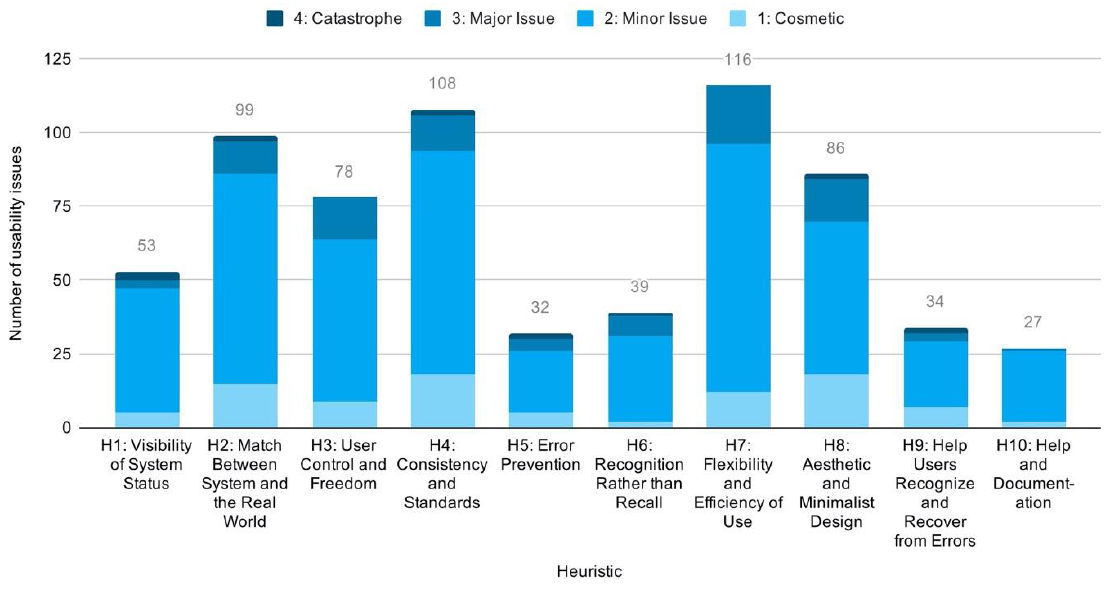
Figure 9. Distribution of issues by heuristic.